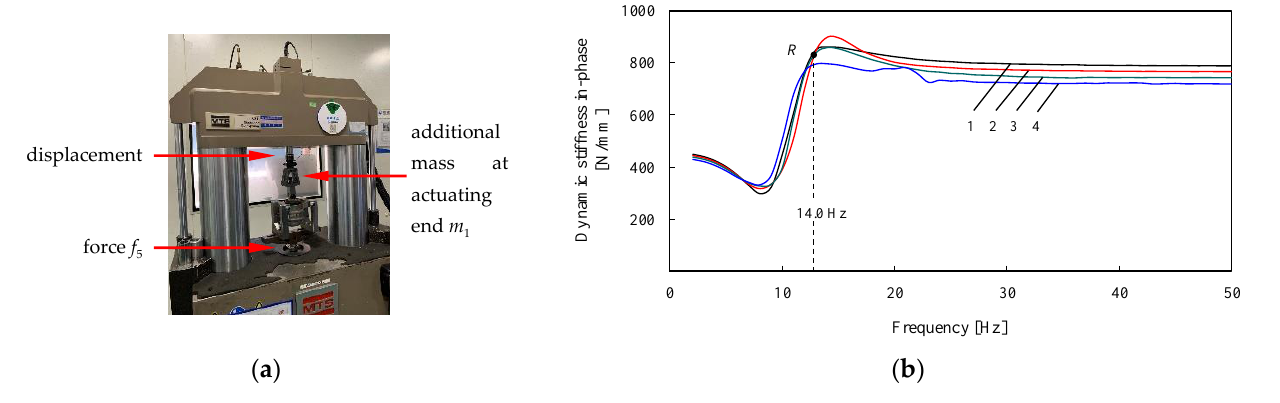
Figure 4. Experimental validation of passive dynamics in mid- and low-frequency bands . ( a ) ex- perimental setup, ( b ) dynamic stiffness in-phase. Key : the numbers 1–4 correspond to the excitation amplitudes of Y 1 = 0.4 mm, 0.6 mm, 0.8 mm, and 1.0 mm, respectively; R is the fixed point in dynamic stiffness in-phase.